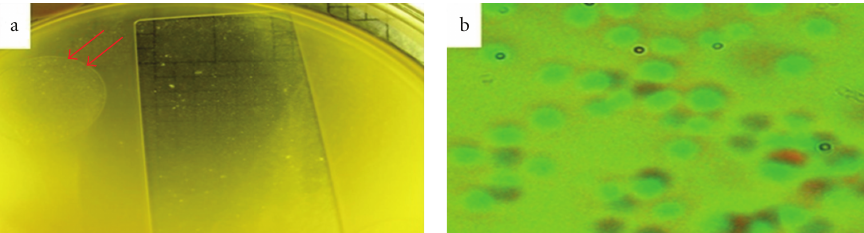
Figure 4: Direct visualisation of bacterial auto-aggregation in liquid culture media of the non-adherent Staphylococcus epidermidis ATCC 12228 reference strain on a glass coverslip surface after a 48 h incubation using a colony counter lens (a) and the Nikon Eclipse light microscope